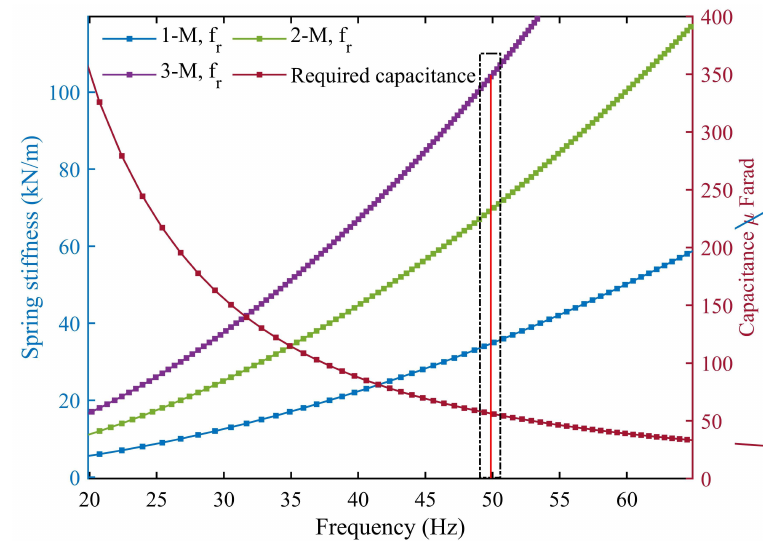
Figure 17. Required capacitor value and spring constant at different operating